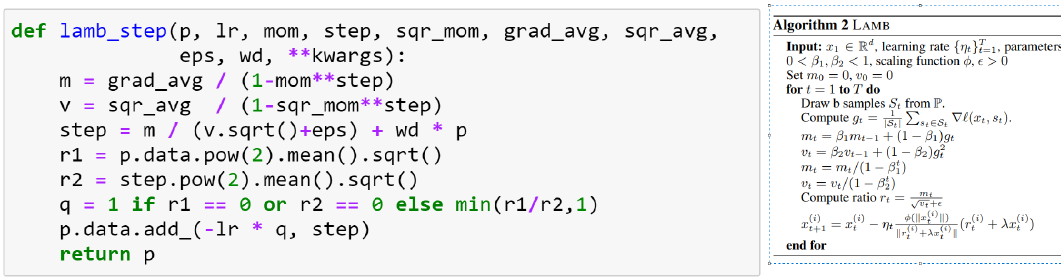
Figure 10. The LAMB algorithm and